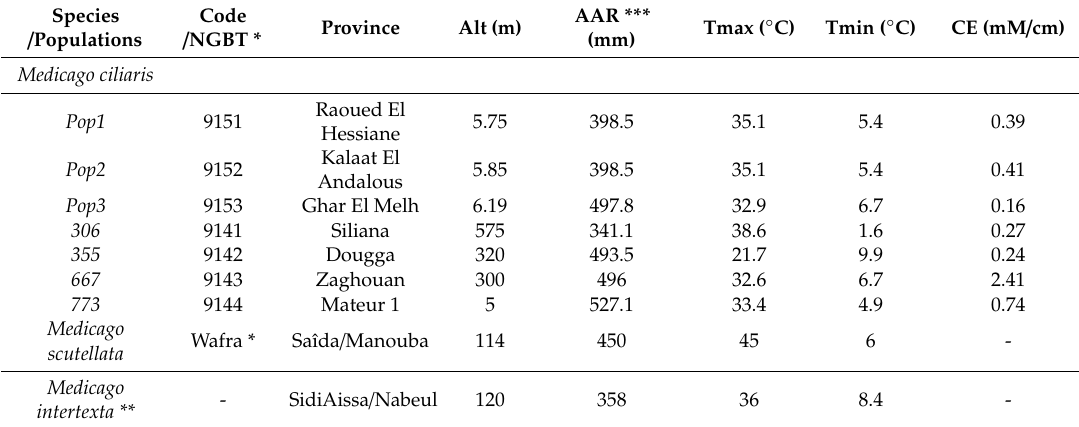
Table 6. Geographical origins and characteristics of the studied populations of Medicago ciliaris , Medicago scutellata , and Medicago intertexta